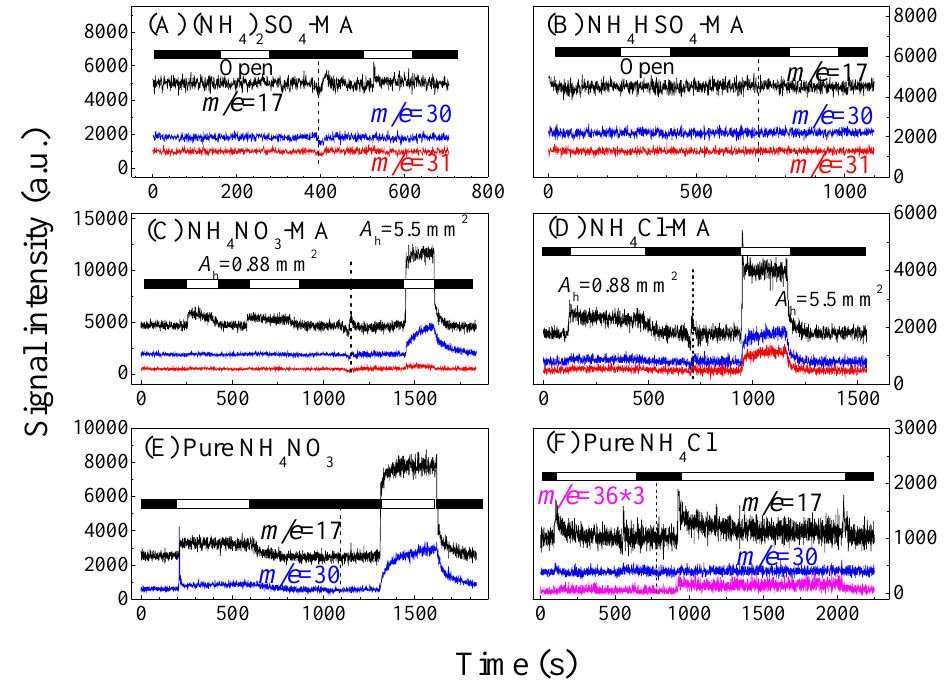
Fig. 3. Desorption of surface species from MA treated salts and pure salts at 1.2 × 10 − 6 Torr and at 298K. (A) 58.2mg (NH 4 ) 2 SO 4 , (B) 60.5mg NH 4 HSO 4 , (C) 59.8mg NH 4 NO 3 , (D) 63.9mg NH 4 Cl, (E) 59.8mg pure NH 4 NO 3 and (F) 60.5mg pure NH 4 Cl. The A h